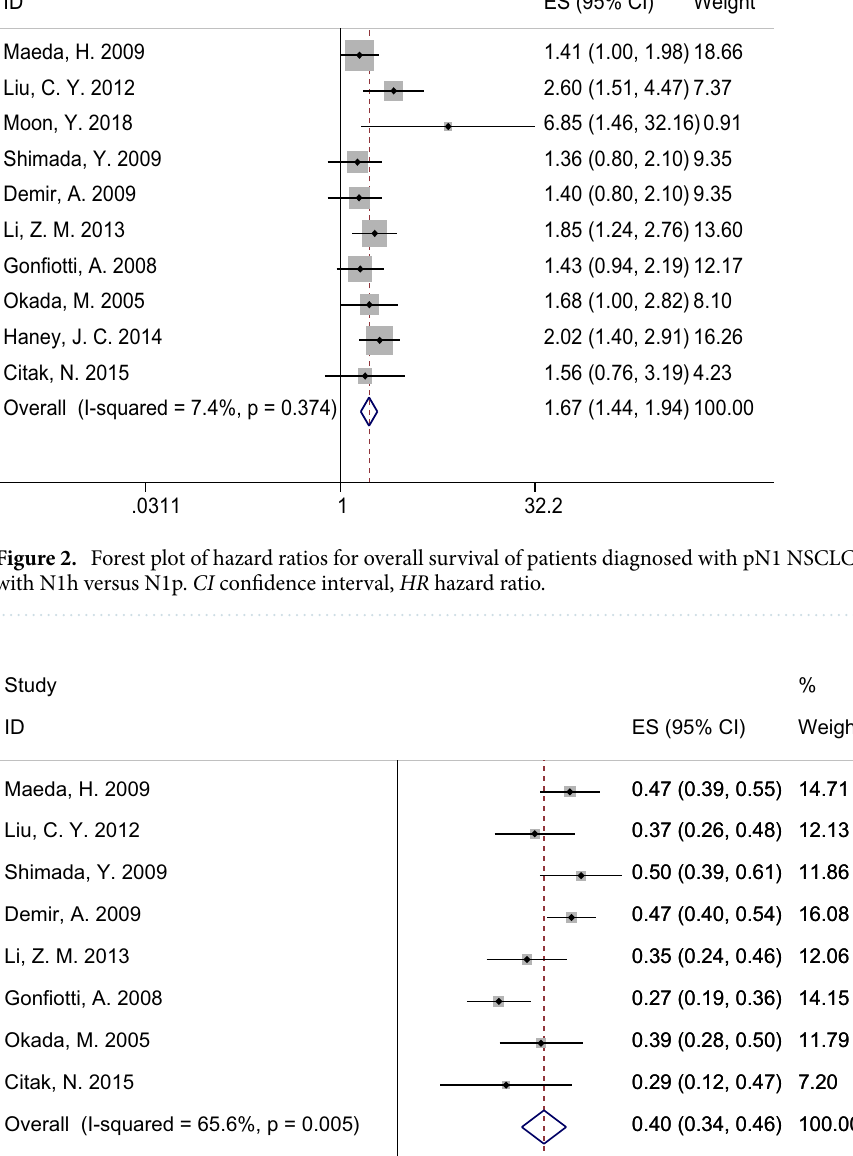
Overall (I-squared = 65.6%, p =